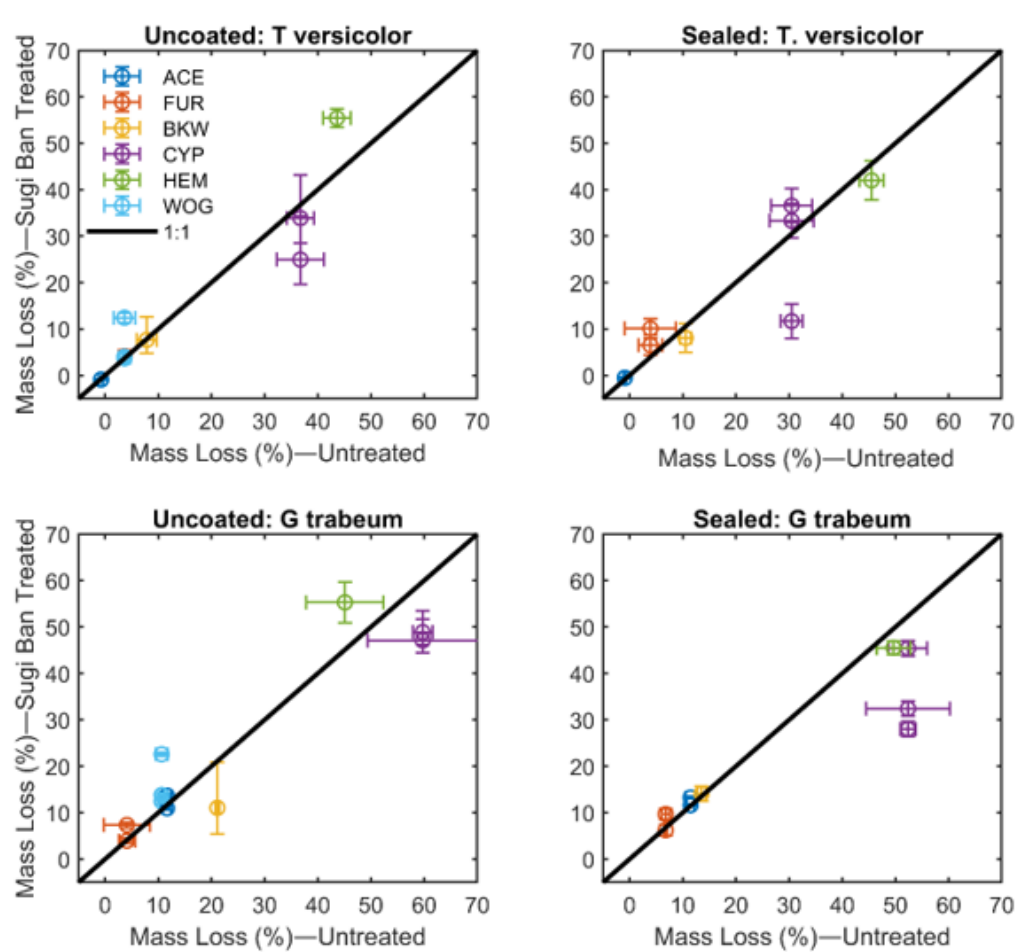
Figure 2. Mass loss caused by decay fungi measured in the soil bottle tests. The error bars represent the standard deviation.